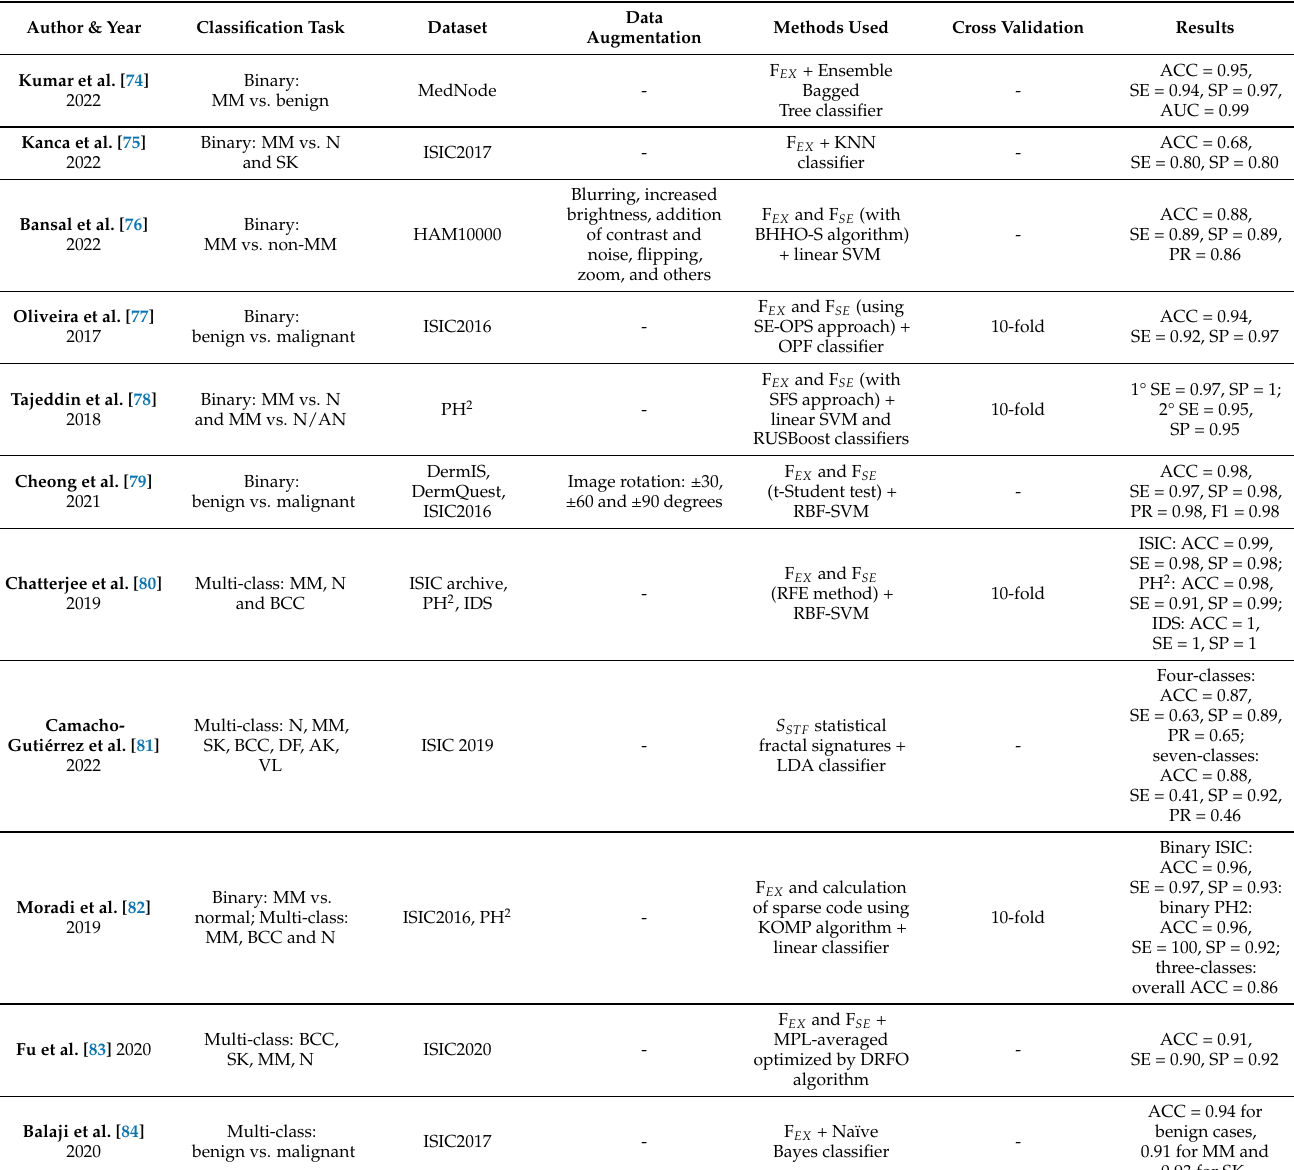
Table 4. Overview of cited works using ML approaches (results have been rounded). F EX and F SE abbreviations are used for feature extraction and selection, respectively. The symbol “-” indicates that no information is provided on a particular